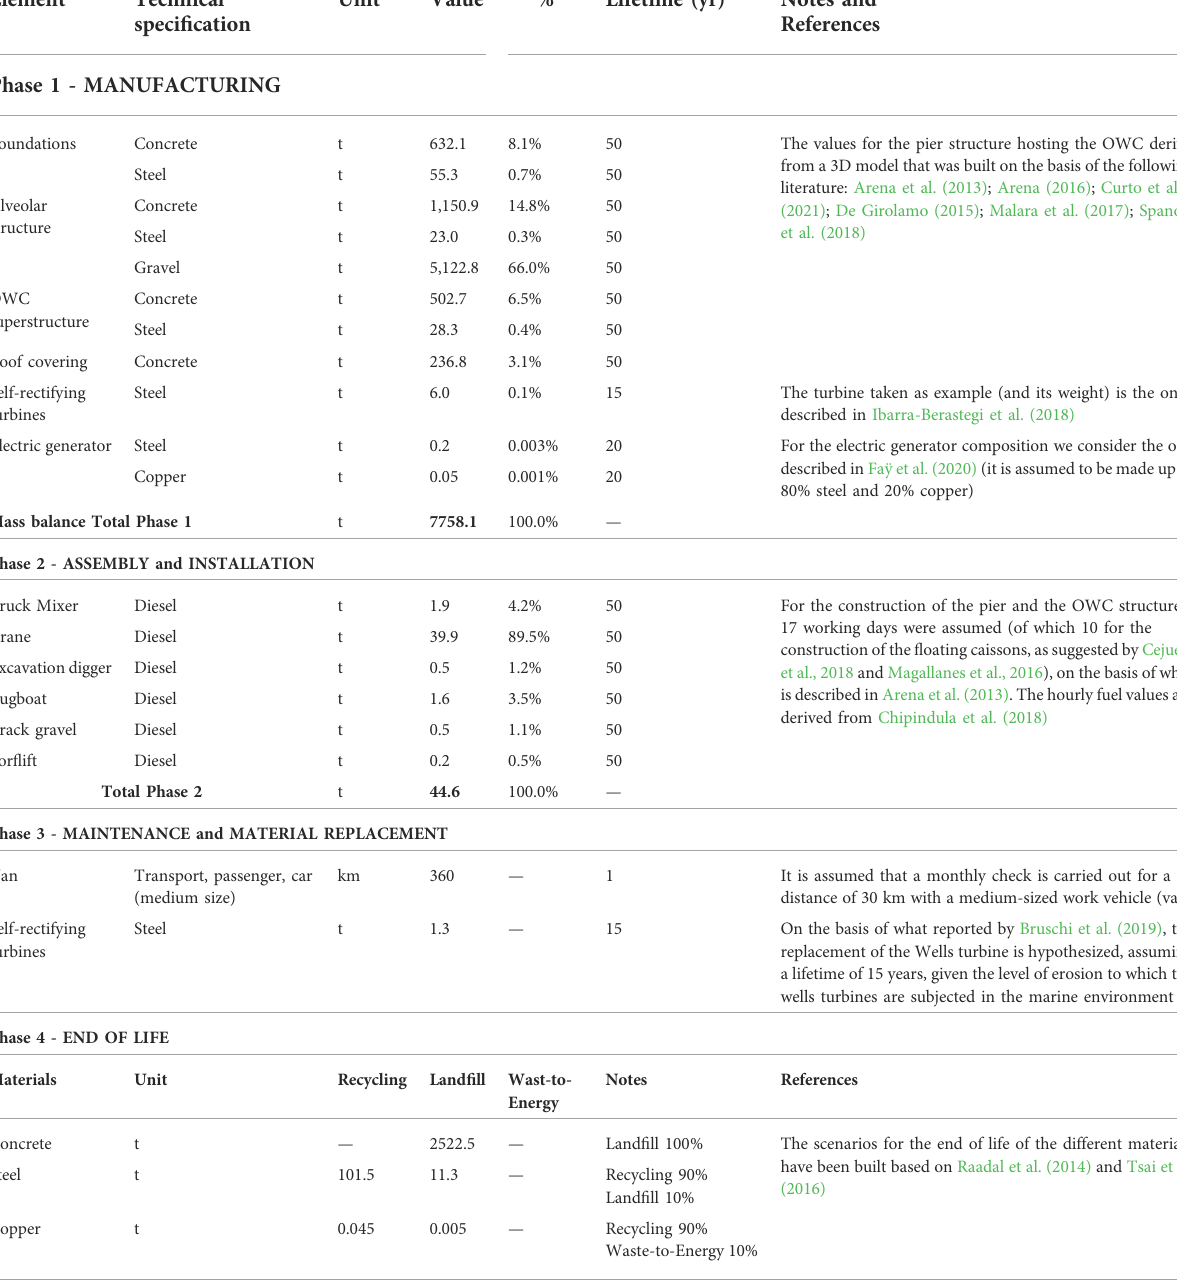
TABLE 2 Life Cycle Inventory data for a 20 m breakwater hosting 5 generic OWC systems. Values in bold represent totals and